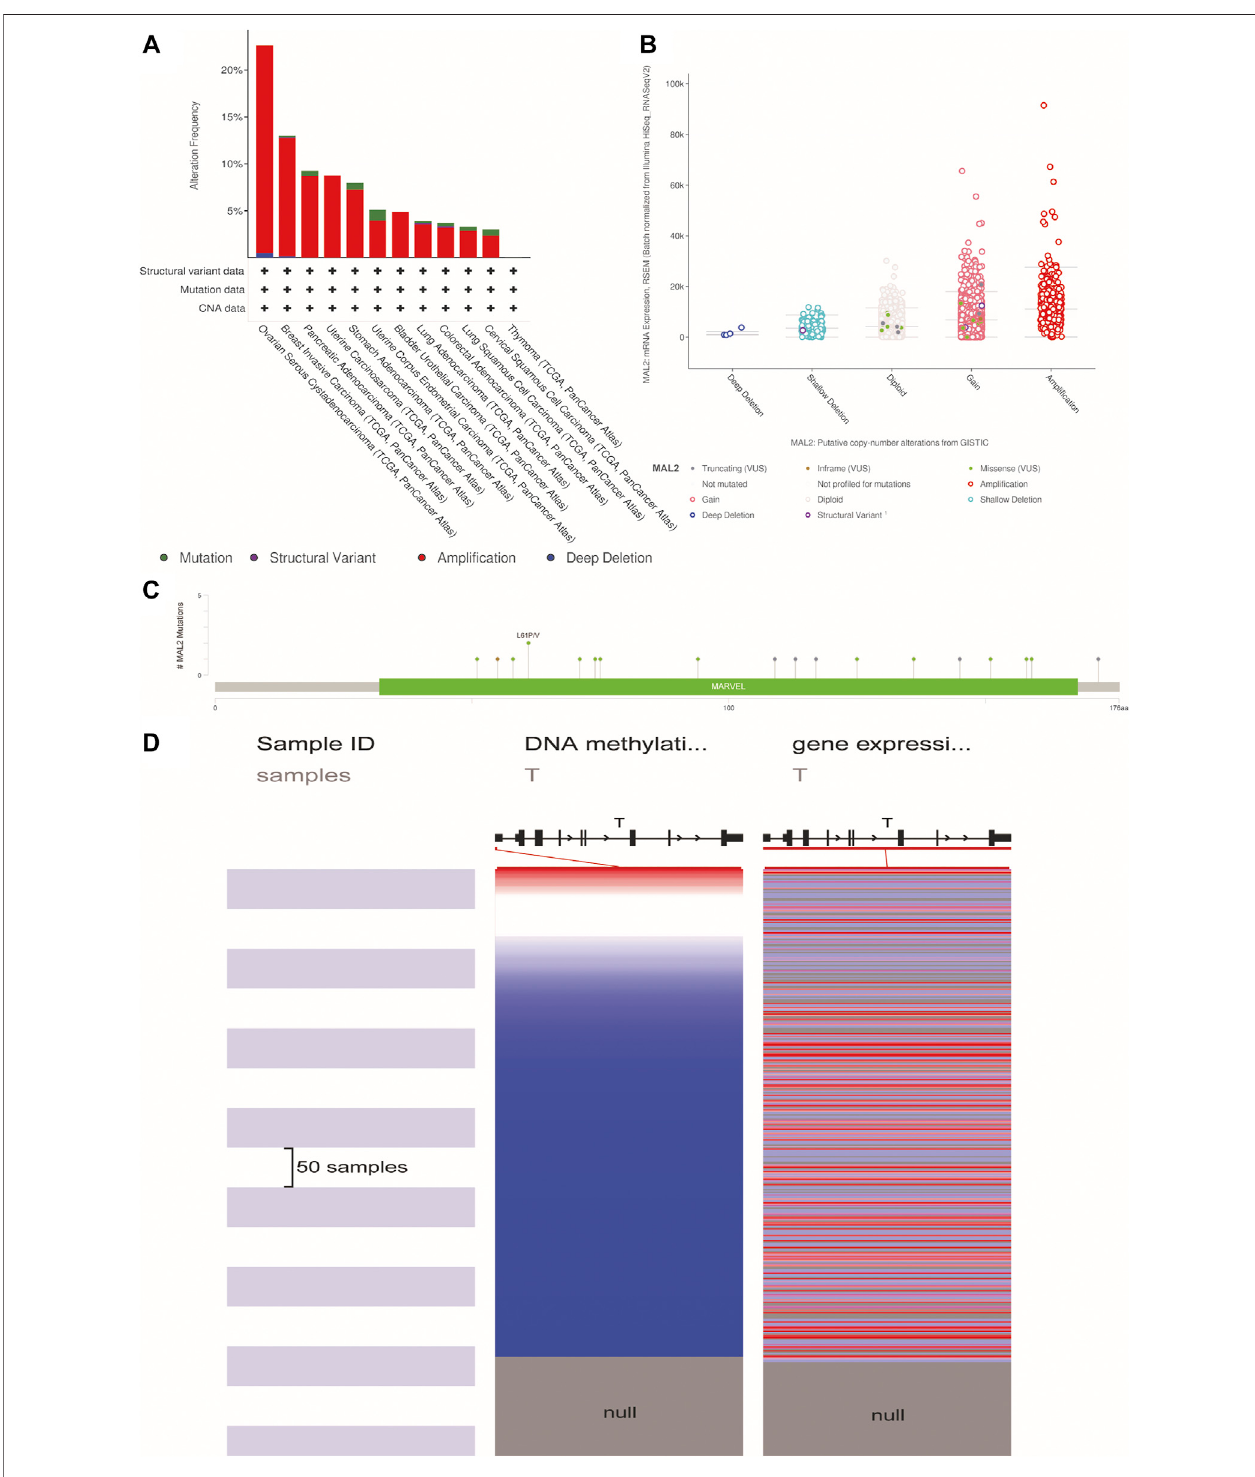
FIGURE 3 | The alteration of MAL2 in pan-cancers. (A) MAL2 mutation level in The Cancer Genome Atlas (TCGA) database. (B) Putative copy-number alterations from GISTIC. (C) Mutation diagram of MAL2 across protein domains. (D) Heatmap of MAL2 DNA methylation and mRNA expression by the Xena browser.